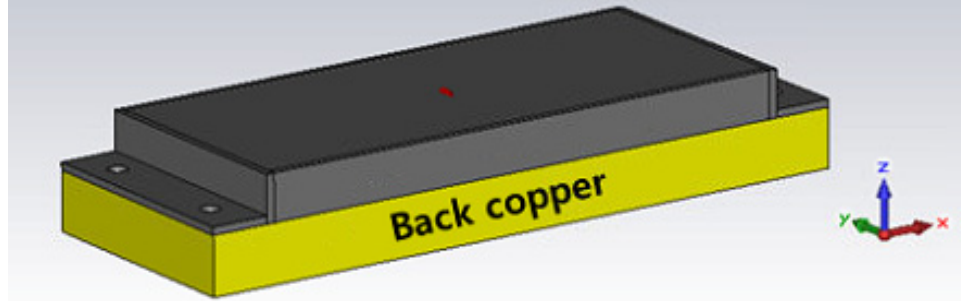
Figure 5. Shape of the antenna on the back copper material mimic attached on the metal object.